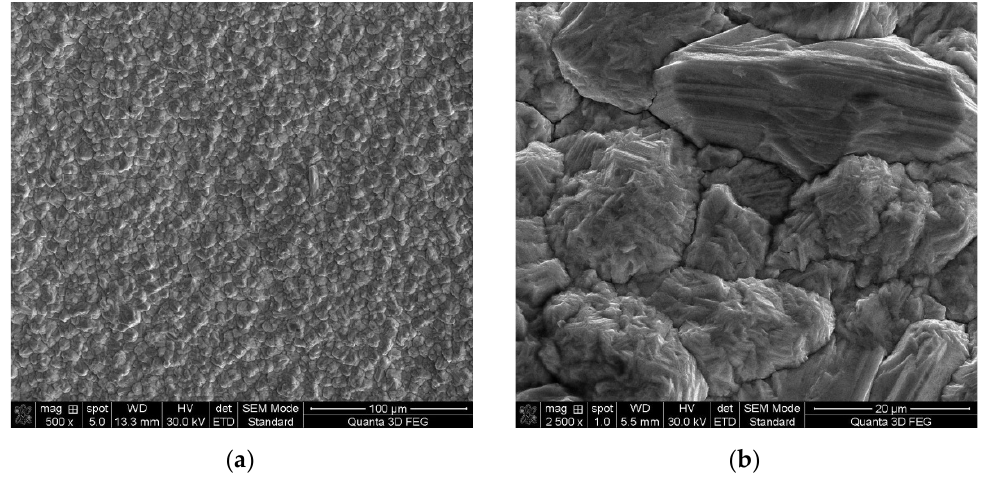
Figure 2. SEM images for the copper deposit at magnitude: ×500 ( a ); ×2500 ( b ).